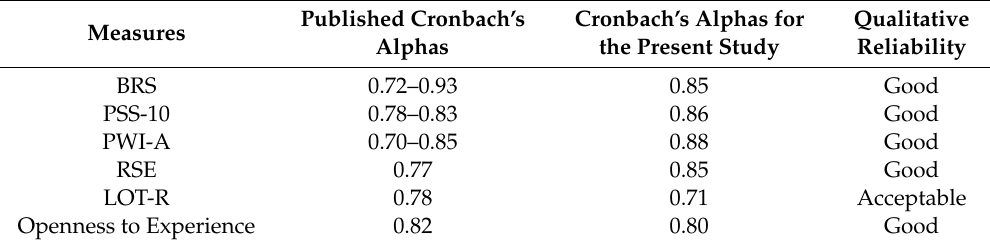
Table 2. Cronbach’s Alphas for the Psychological